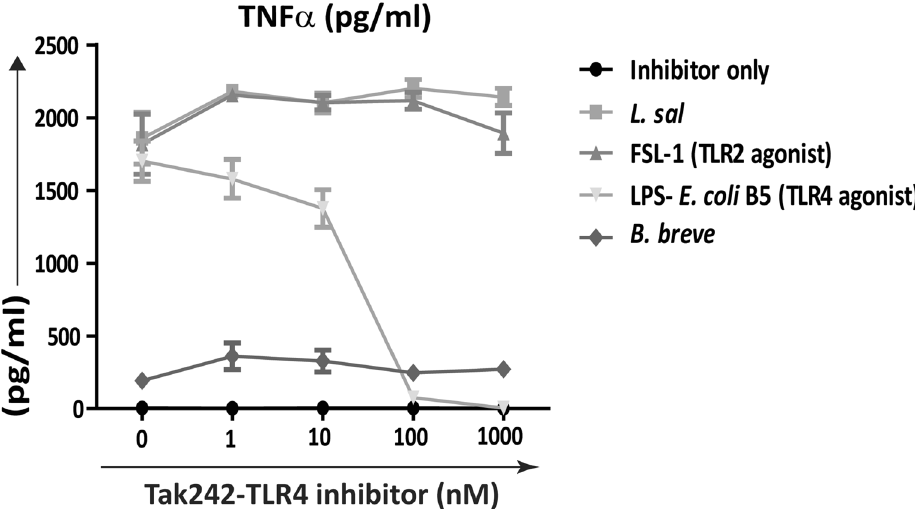
Figure 5. L. salivarius induced cytokine responses are TLR4 independent in Tak242 treated murine WT BMDMs. WT BMDMs were either treated with TLR4 inhibitor (Tak242) alone (inhibitor only) at the indicated concentrations or Tak242 was co-treated with TLR2/6 agonist (FSL-1), TLR4 agonist (LPS) or co- cultured with B. breve and L. salivarius UCC118 at MOI 10 for 20 h. TNF-α concentration (pg/ml) was analysed post 20 h using TNF-α ELISA duosets. Data shown are the average of triplicate wells of three independent experiments (n =